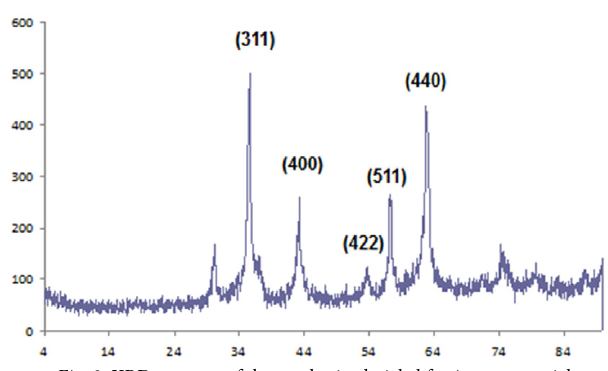
Fig. 2. XRD patterns of the synthesized nickel ferrite nanoparticles. Fig. 3.